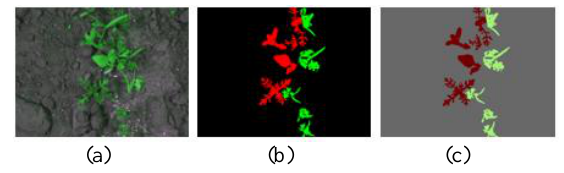
Figure 1. Sample training image. ( a ) training image; ( b ) labeled image, ( c ) the image relabeled using MATLAB tool.